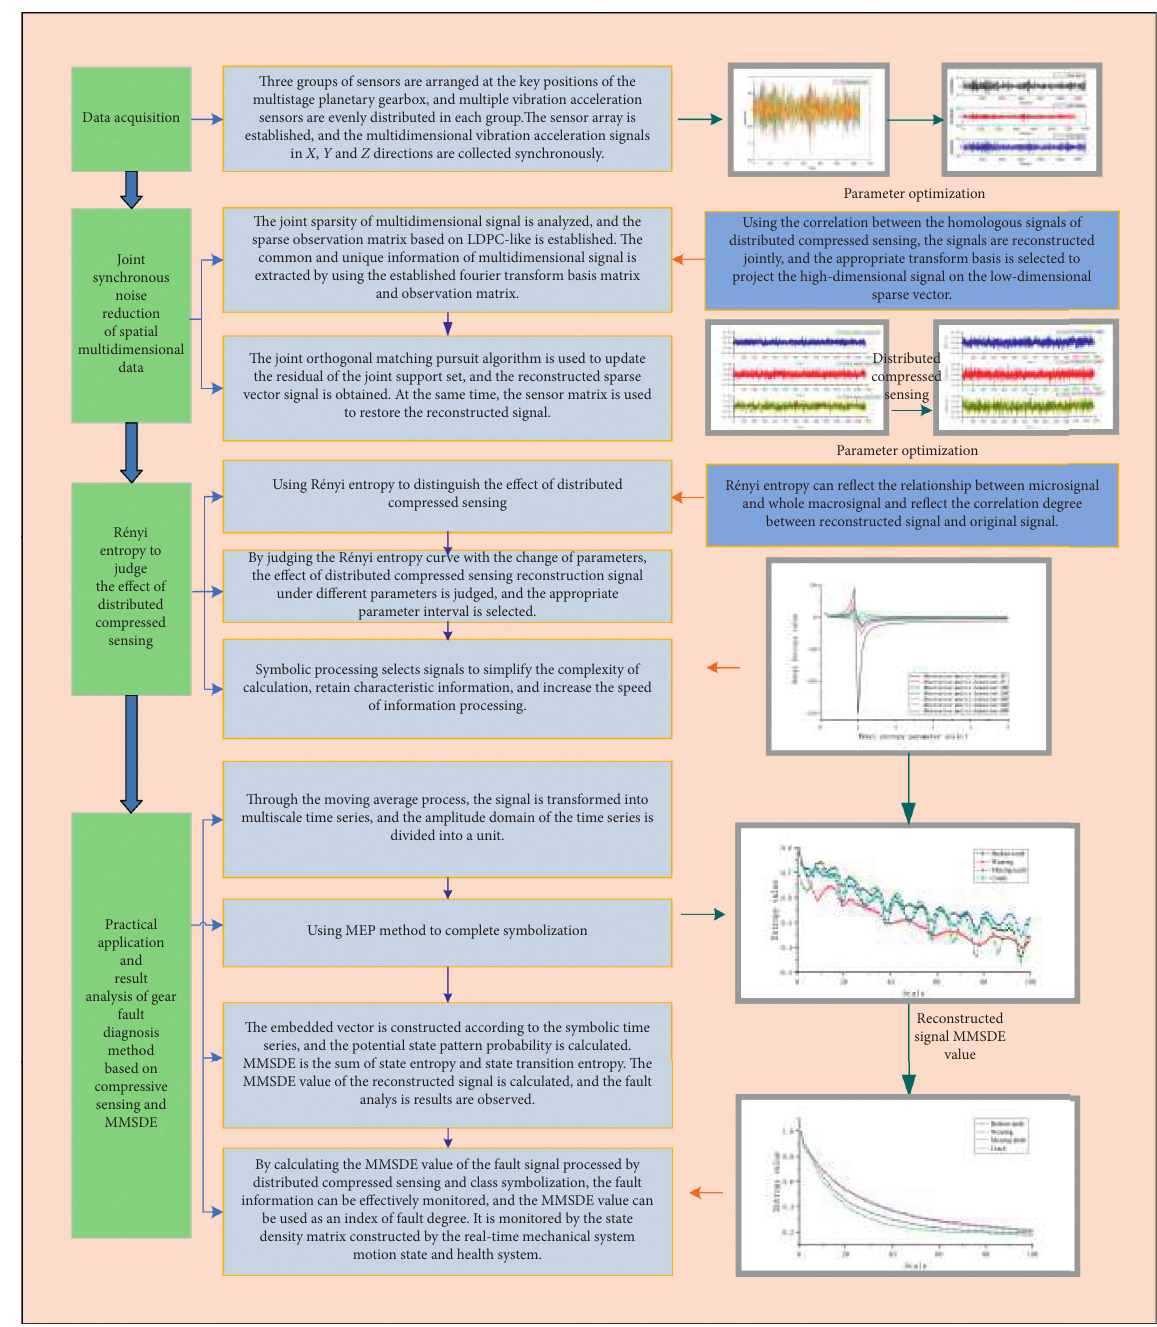
Figure 1: Process of fault analysis method based on distributed compressed sensing multiscale permutation entropy (PE).